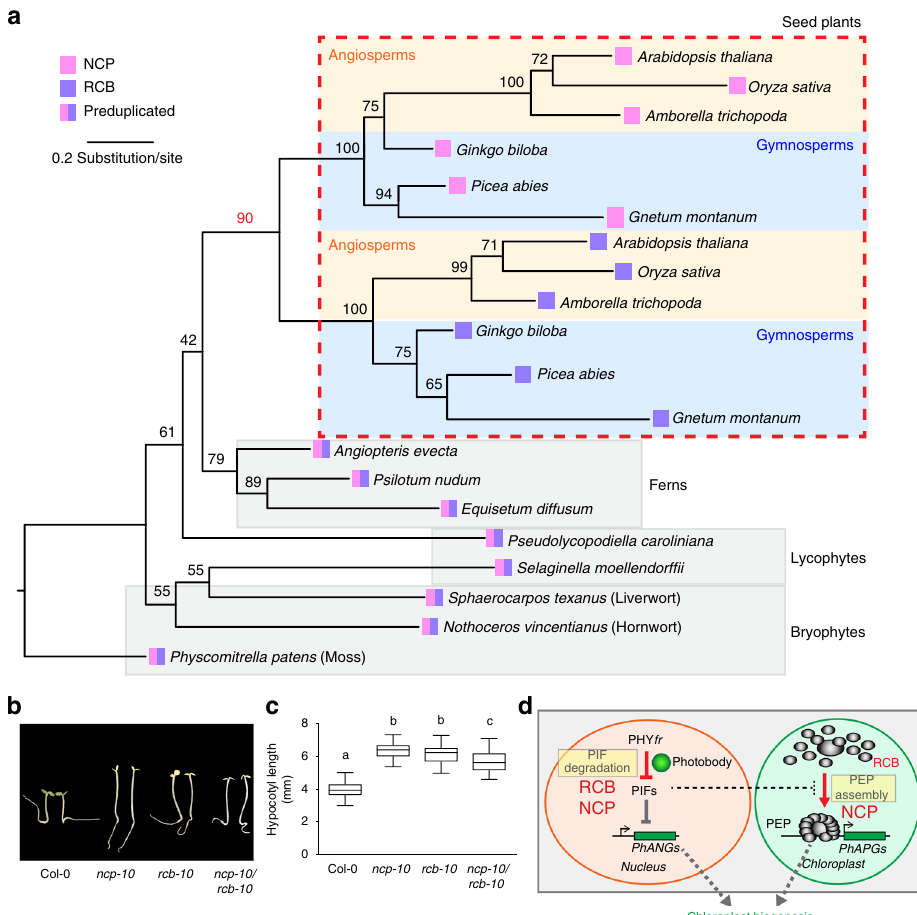
Fig. 5 NCP and RCB diverged in seed plants to adopt distinct roles in PHY signaling. a Maximum likelihood phylogenetic tree of NCP and RCB from seed plants, ferns, lycophytes, and bryophytes. The gene IDs of the sequences used for the phylogenetic analysis are listed in Supplementary Table 4. The phylogenetic tree was constructed using the Randomized Axelerated Maximum Likelihood method. The numbers at each node indicate the bootstrap value (%) from 1000 replications. The length of the branches represents the extent of divergence based on the scale at the bottom. b Representative images